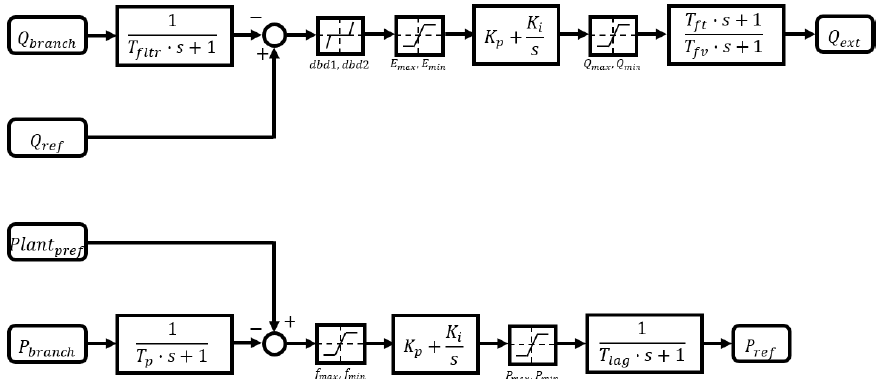
Figure 7. The simplified universal model of the WECC energy storage systems — REPC module .